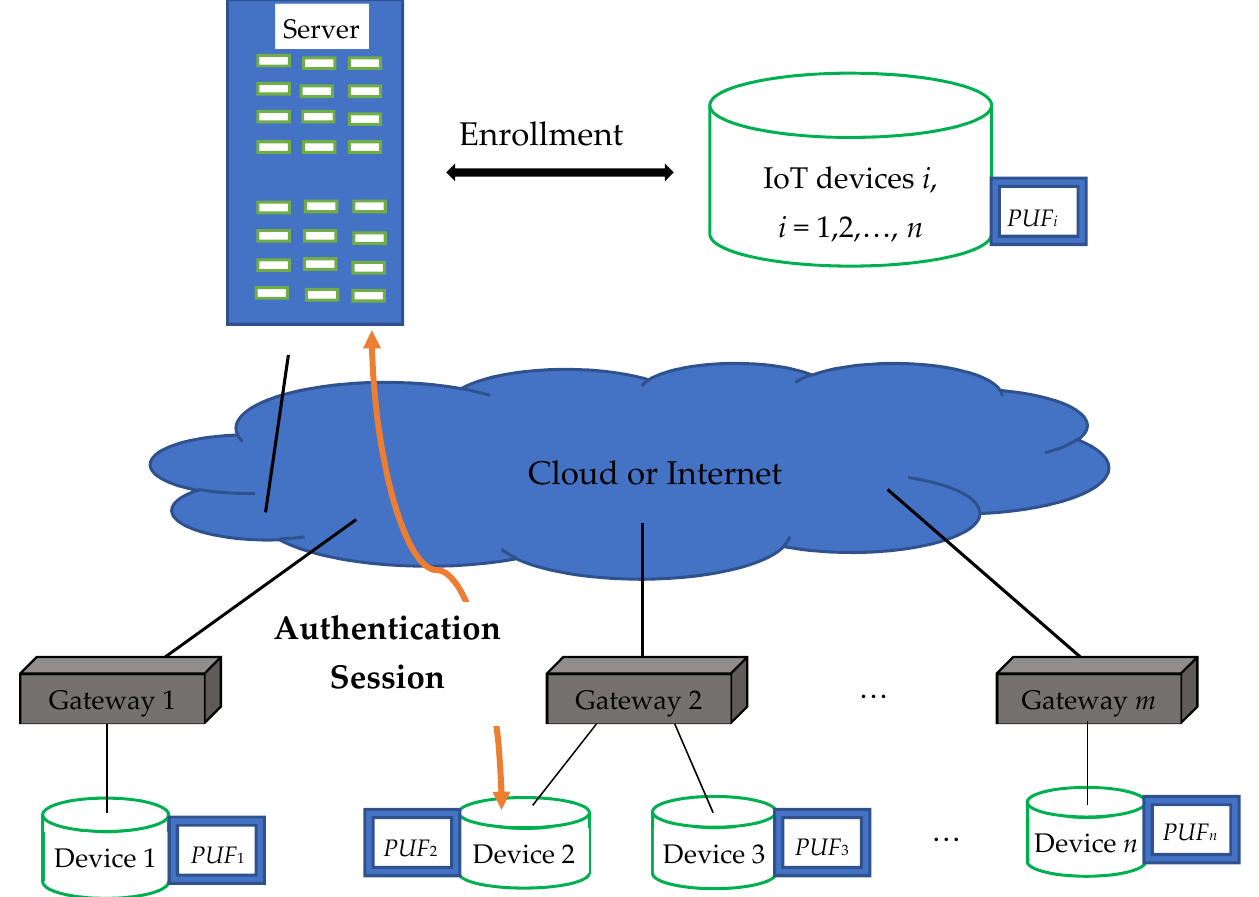
Figure 3. Zerrouki et al.’s system model.